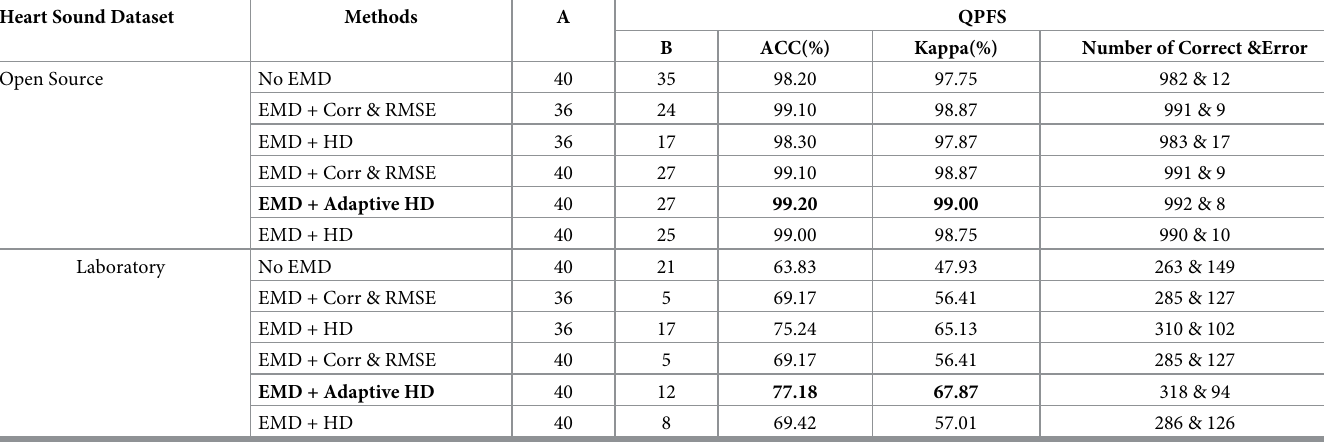
Table 6. Comparison of accuracy and feature dimension under different methods based on QPFS. Heart Sound